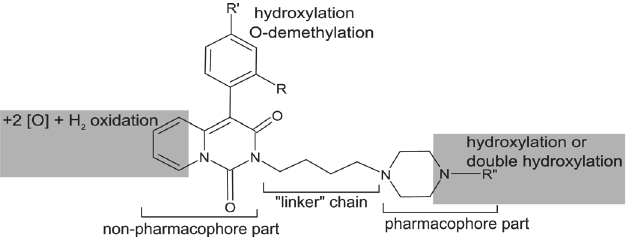
Fig 6. General structure of the studied compounds along with sites of metabolism and types of reactions that occur in those sites.